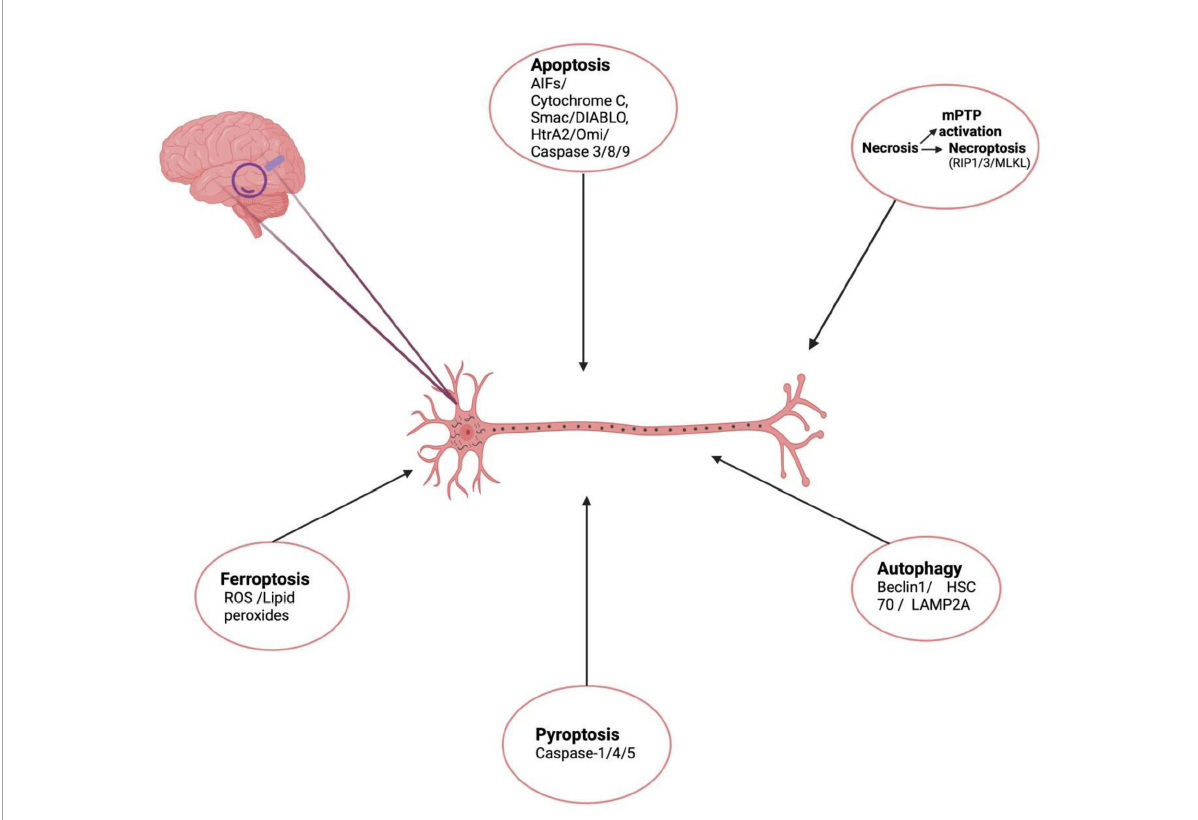
FIGURE1 Schematic representation of cell death mechanisms responsible for neuronal death in AD. (Created with BioRender.com.) Apoptosis – initiated inner mitochondrial membrane changes leads to release of cytochrome c, AIF, Smac/DIABLO, HtrA2/Omi, activates effector caspases and causes apoptotic cell death. Necroptosis – is a form of RCD involving RIPK1, RIPK3, necrosome formation and MLKL activation. Another form of necrosis mPTP leading to rupture of outer membrane and non-specific release of intermembrane space proteins into cytosol, causing cell death. Autophagy – another cell death mechanism mediated by Beclin 1, HSC70, LAMP2A leads to formation of LC3II autolysosomes causing cell death. Pyroptosis – lytic form of cell death associated with inflammasomes formation, activation caspase-1/4/5 Gasdermin-D cleavage and release of inflammatory cytokines is also responsible for neuronal cell death in AD. Ferroptosis – Iron-dependent mode of cell death, induced by diverse triggers involves ROS, lipid peroxide accumulation depleted glutathione